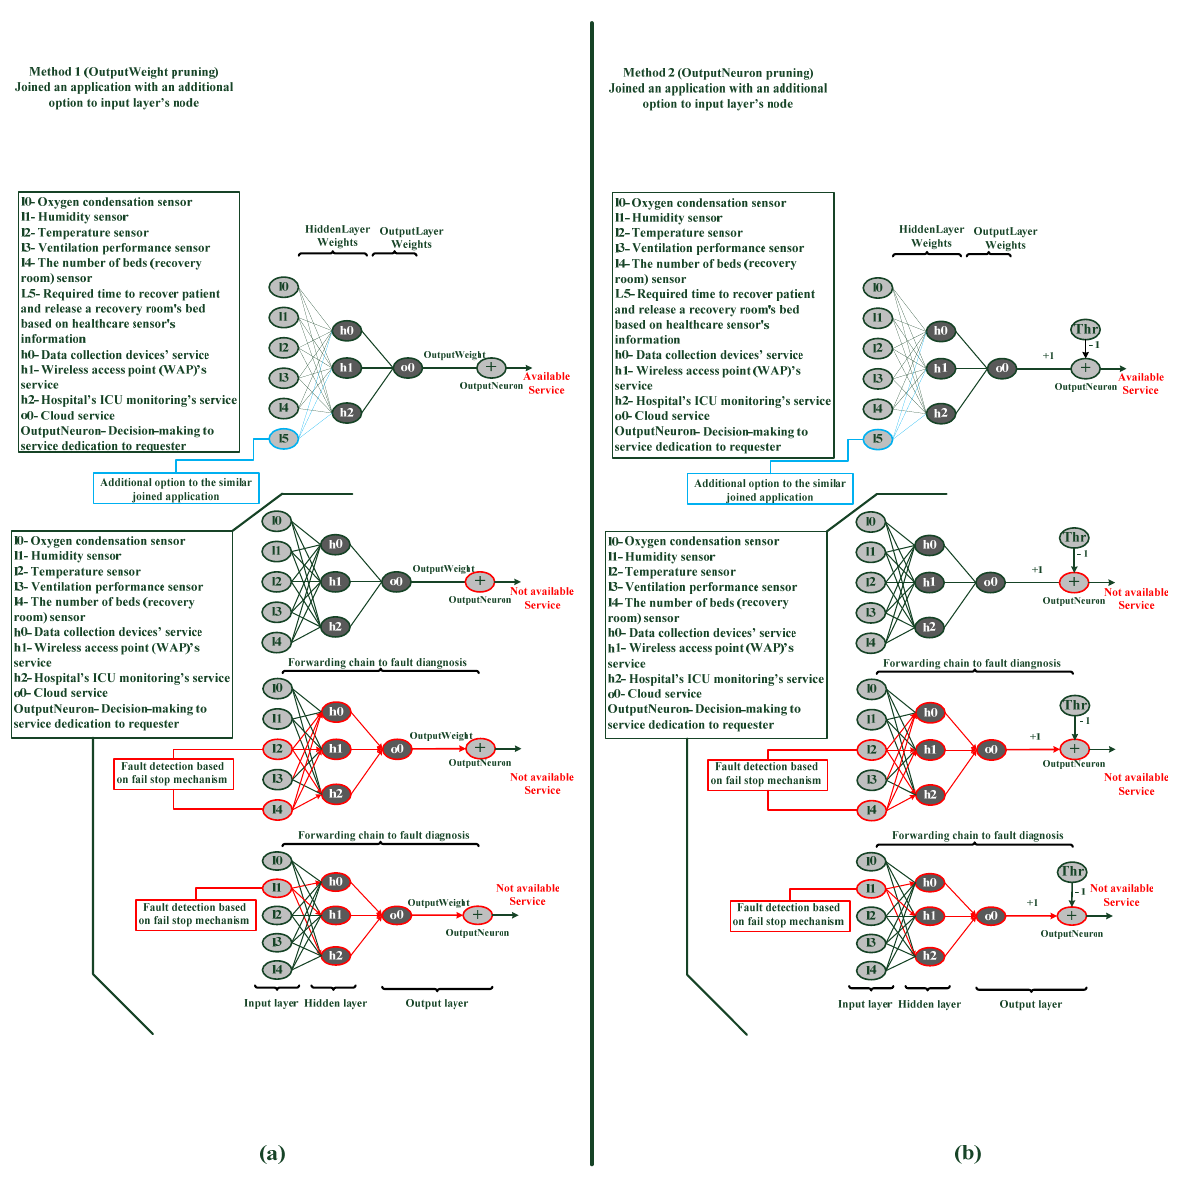
Figure 9. The efficiency of a similar joined application with an additional option for different methods to decision-making about dedicating service to a requester with high quality and forwarding chain to fault detection: ( a ) Method 1 based on pruning weak weight (output weight) and output neuron in output layer; ( b ) Method 2 based on pruning weak output neuron in the output layer.